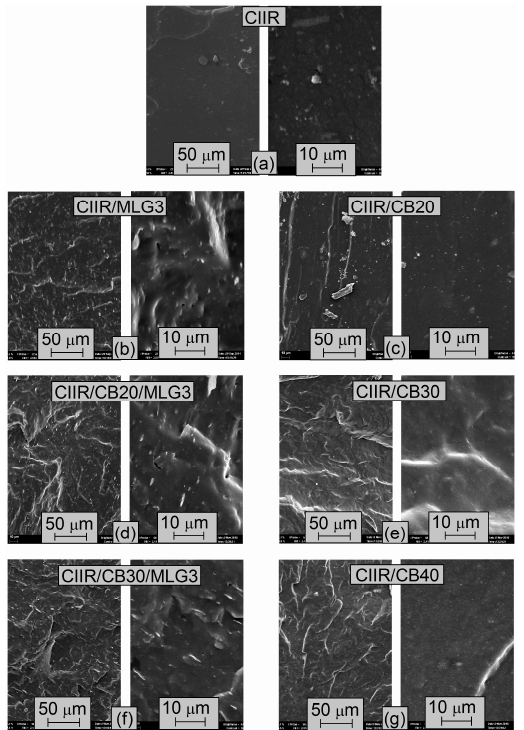
Figure 7. ( a )–( g ) SEM micrographs of CIIR and its composites.